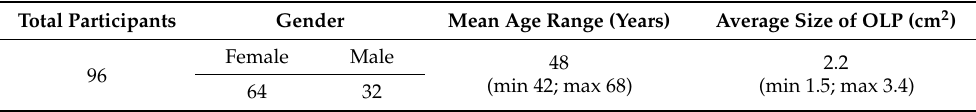
Table 1. Clinical features of the treated